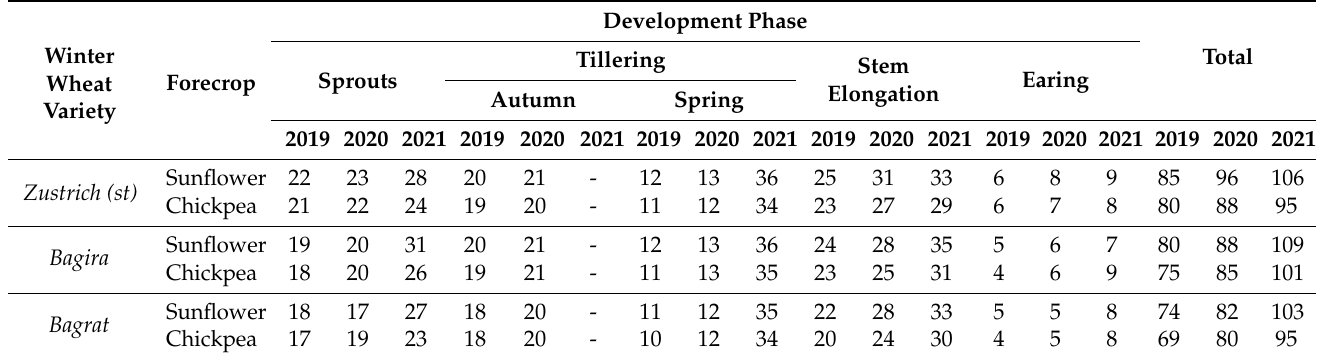
Table 2. Duration of interphase periods,